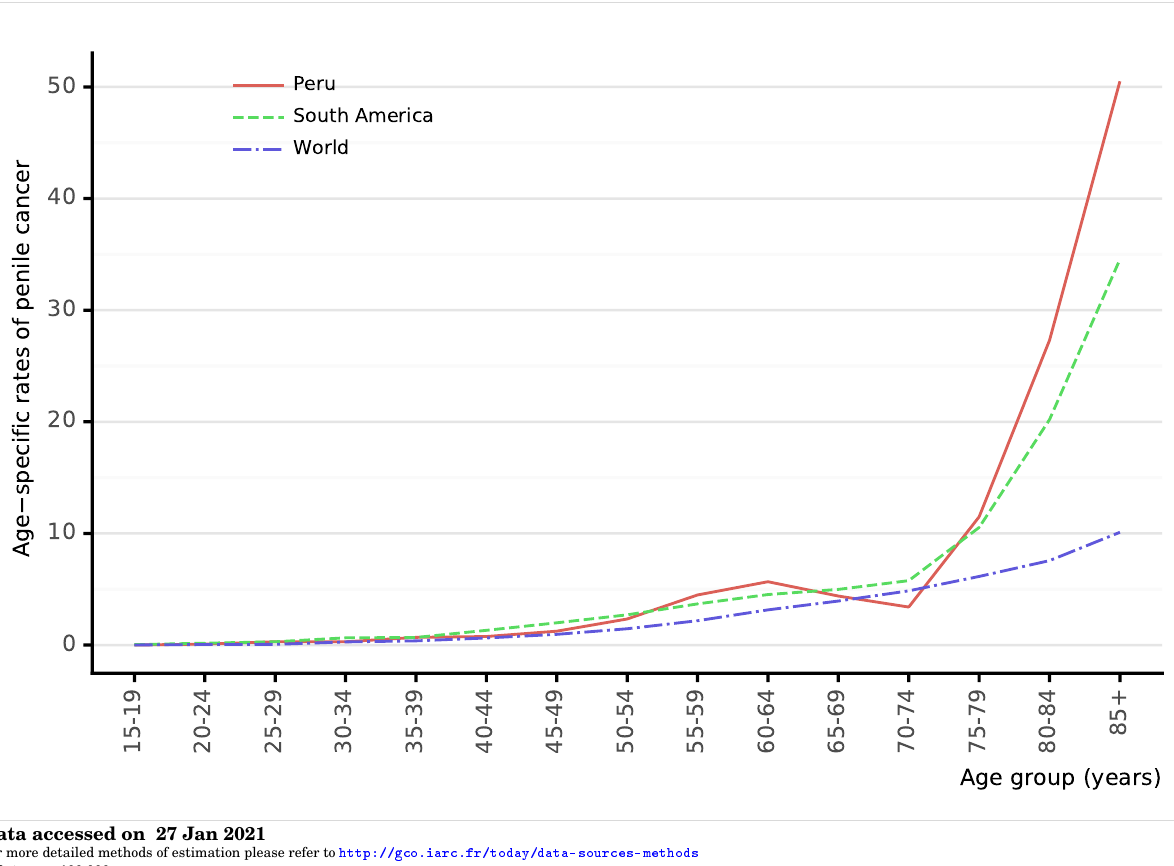
Figure 89: Comparison of age-specific penile cancer incidence rates in Peru, within the region, and the rest of